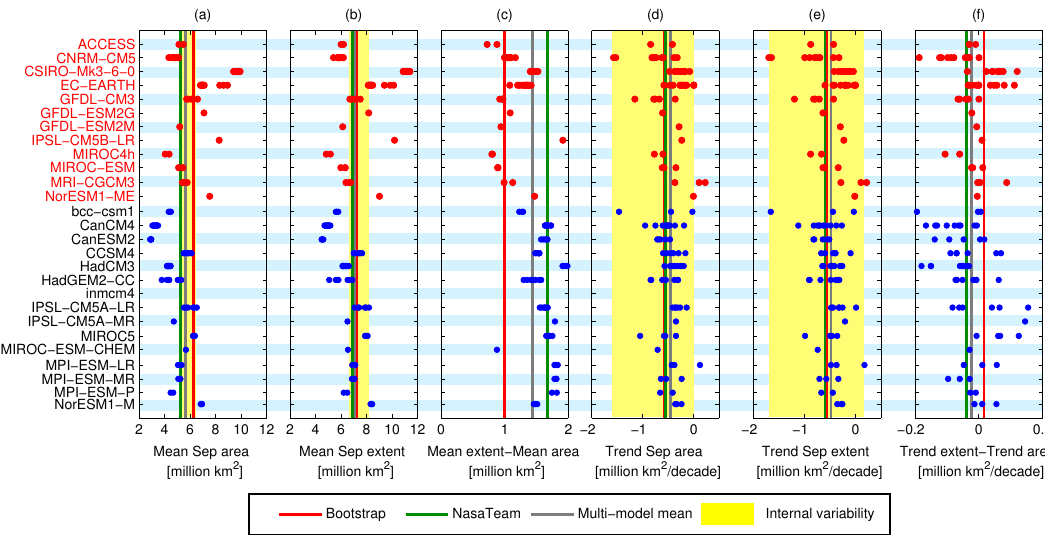
Fig. 5. Overview of the September sea-ice coverage in the 117 historical CMIP5 simulations analysed for this study. Each individual dot corresponds to a single simulation. The vertical lines show the values of the observational record and the mean of all simulations. The yellow shading indicates estimated internal variability. All data refer to the period 1979–2005. (a) Mean September sea-ice area, (b) mean September sea-ice extent, (c) difference between mean September sea-ice extent and mean September sea-ice area, (d) linear trend in September sea-ice area, (e) linear trend in September sea-ice extent, (f) difference between trend in September sea-ice extent and trend in September sea-ice area. Models with a compact ice cover are labelled in